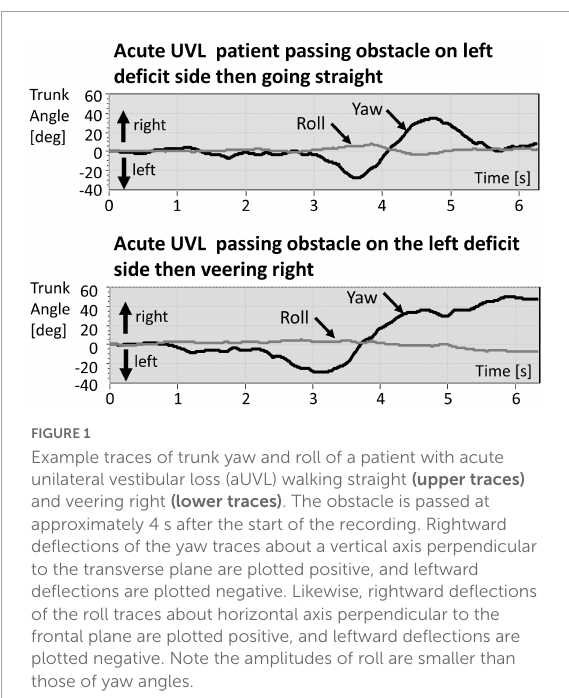
FIGURE1 Example traces of trunk yaw and roll of a patient with acute unilateral vestibular loss (aUVL) walking straight (upper traces) and veering right (lower traces) . The obstacle is passed at approximately 4 s after the start of the recording. Rightward deflections of the yaw traces about a vertical axis perpendicular to the transverse plane are plotted positive, and leftward deflections are plotted negative. Likewise, rightward deflections of the roll traces about horizontal axis perpendicular to the frontal plane are plotted positive, and leftward deflections are plotted negative. Note the amplitudes of roll are smaller than those of yaw